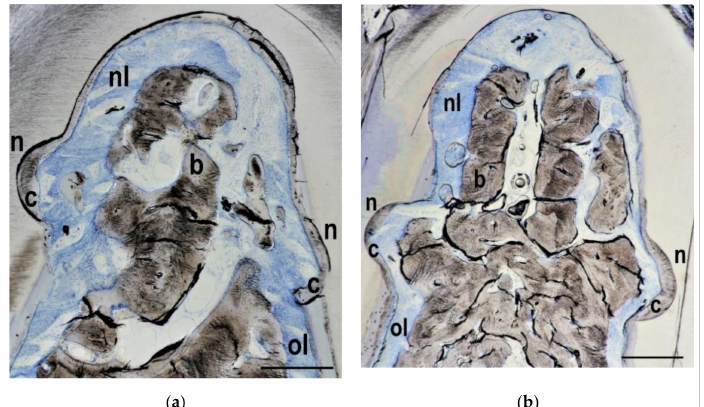
Figure 3. Control group histology from the keyhole ( a ) and the horizontal ( b ) defect types. The notches (n) on both sides as well as the whole defect area have been covered with a layer of new cementum (c) onto the formerly contaminated and debrided root surface. New bone ( b ) has grown into the furcation area and occupied approximately two thirds of the defect height. New periodontal ligament (nl) has formed coronally to the original periodontal ligament (ol). Bar in lower right corner represents 0.5